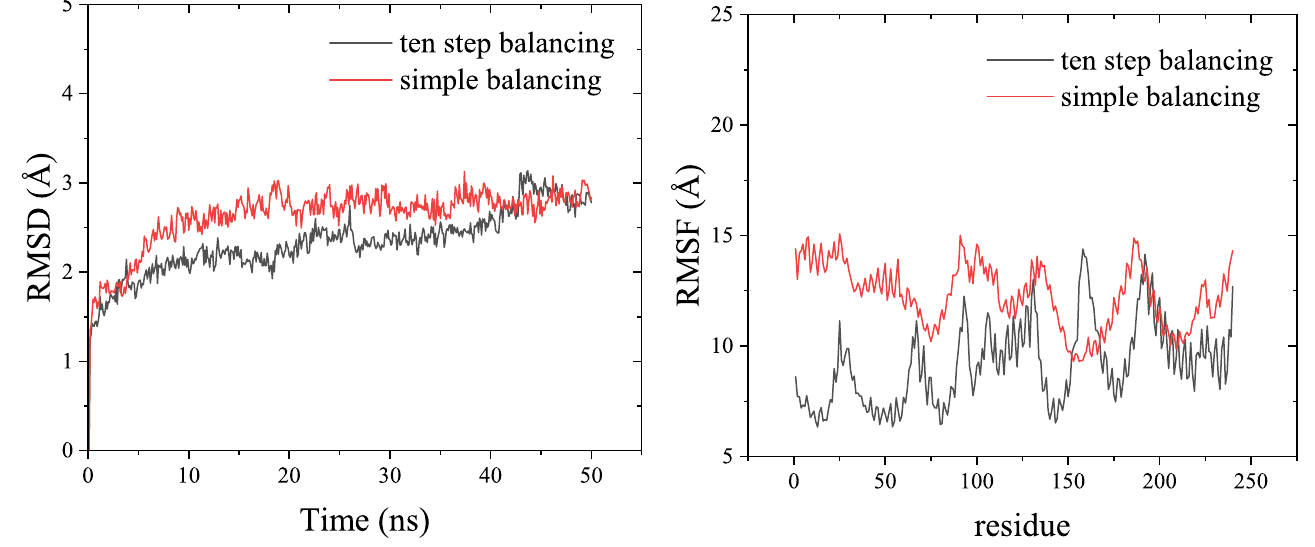
Figure 3. Comparison of the RMSD and RMSF results from 50 ns MD simulations of the raloxifen- estrogen receptor, by the ten-step balancing or simple balancing in the Amber tutorial, using the AmberMDrun